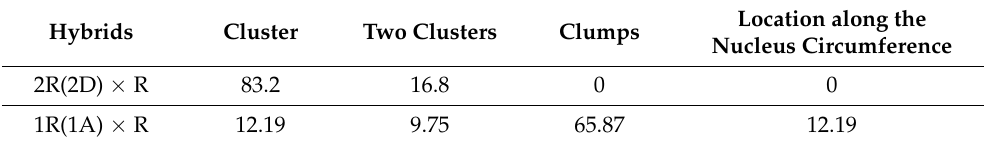
Figure 4. Telomere and centromere dynamics in 1R(1A) × R ( a , c , e – h , j , l ) and 6R(6A) × R ( b , d , i , k ) hybrids. ( a , b ) Leptotene. ( c – h ) Zygotene. ( i , j ) Pachytene, ( k , l ) Diplotene. ( ai – li )—the same as ( a – l ) DAPI counterstaining. Telomeres are stained red , centromeres, green . Scale bar = 10 μ m. Table 2. Percent of meiocytes with different types of rye subtelomere associations at zygotene in wheat–rye F 1 hybrids (ImmunoFISH).